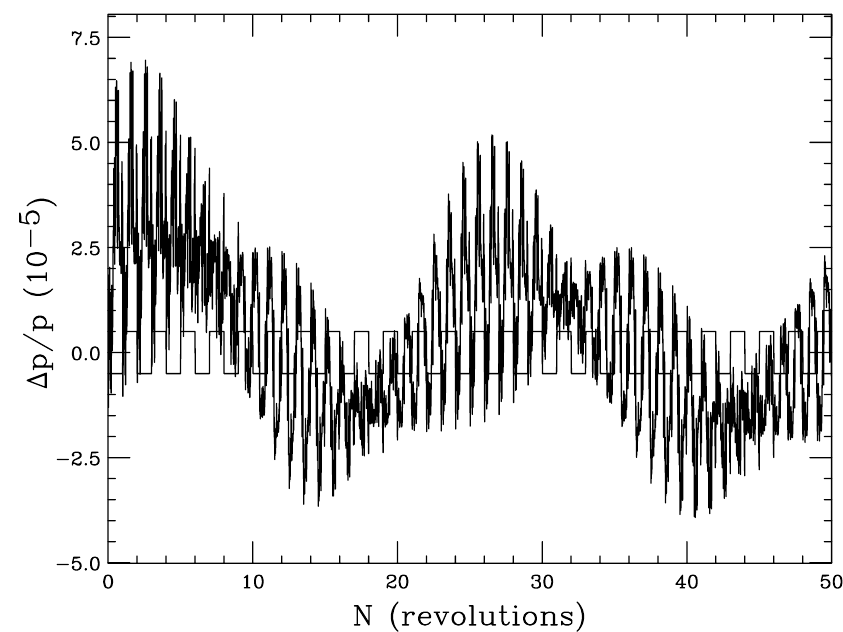
FIG. 12. The turn-by-turn data, divided by the dispersion function, of the synchrotron mode is plotted at each BPM for a total of 50 revolutions, starting from the revolution number 3001. The normalized vertical axis is equivalent to the fractional off-momentum variable. Each square box represents one revolution.